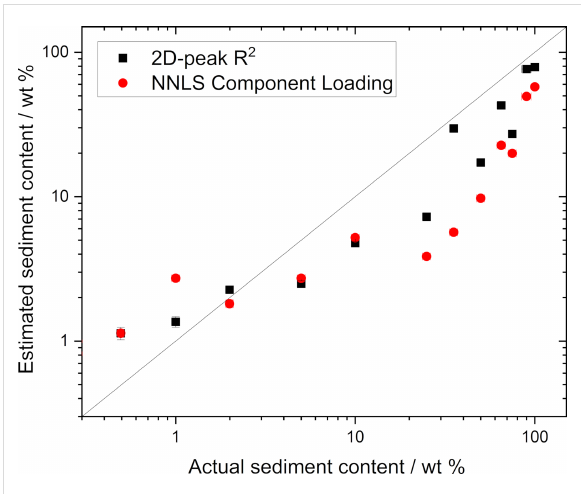
Figure 8: Estimated sediment content calculated from the fraction of measured spectra that are “sediment-like” based on either adjusted R 2 value from fitting the 2D peak or from NNLS fitting. The line shows the expected linear trend, rather than a fit to the data.